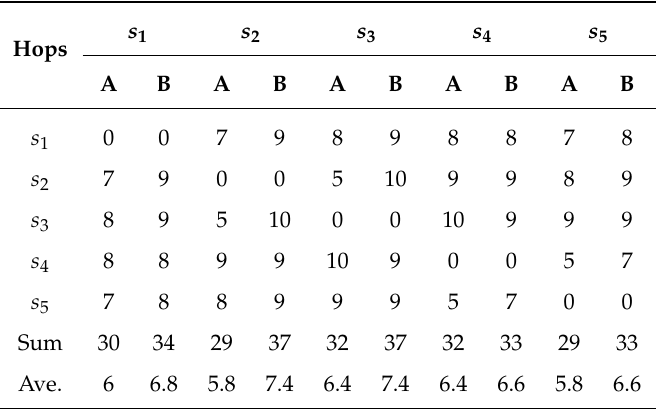
Table 4. OASS vs. Restore Relay Lost Connectivity using zero Gradient Based Point solution (RRLC-GBP) in distance